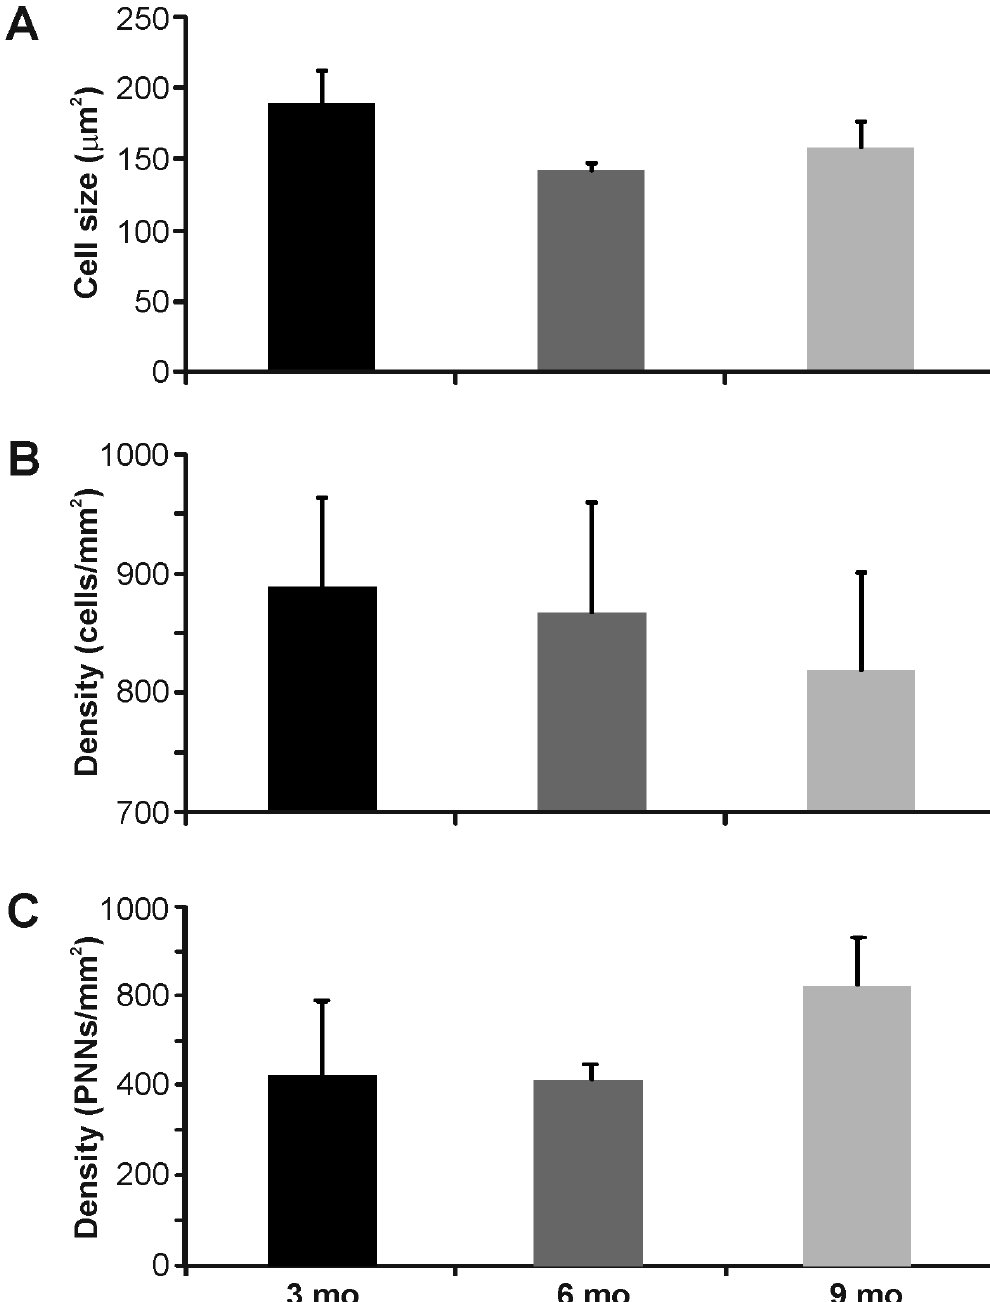
Figure 5. Quantification of size and density of Venus and wisteria floribunda agglutinin (WFA) labeling in the thalamic reticular nucleus (TRN) of the vesicular gamma-amino butyric acid transporeter (VGAT)-Venus C57BL/6 mouse strain: ( A ) size of Venus-positive cell bodies in three different age groups; ( B ) density of Venus-positive cells throughout the TRN; and ( C ) density of perineuronal nets (PNNs) across the TRN. mo: months.